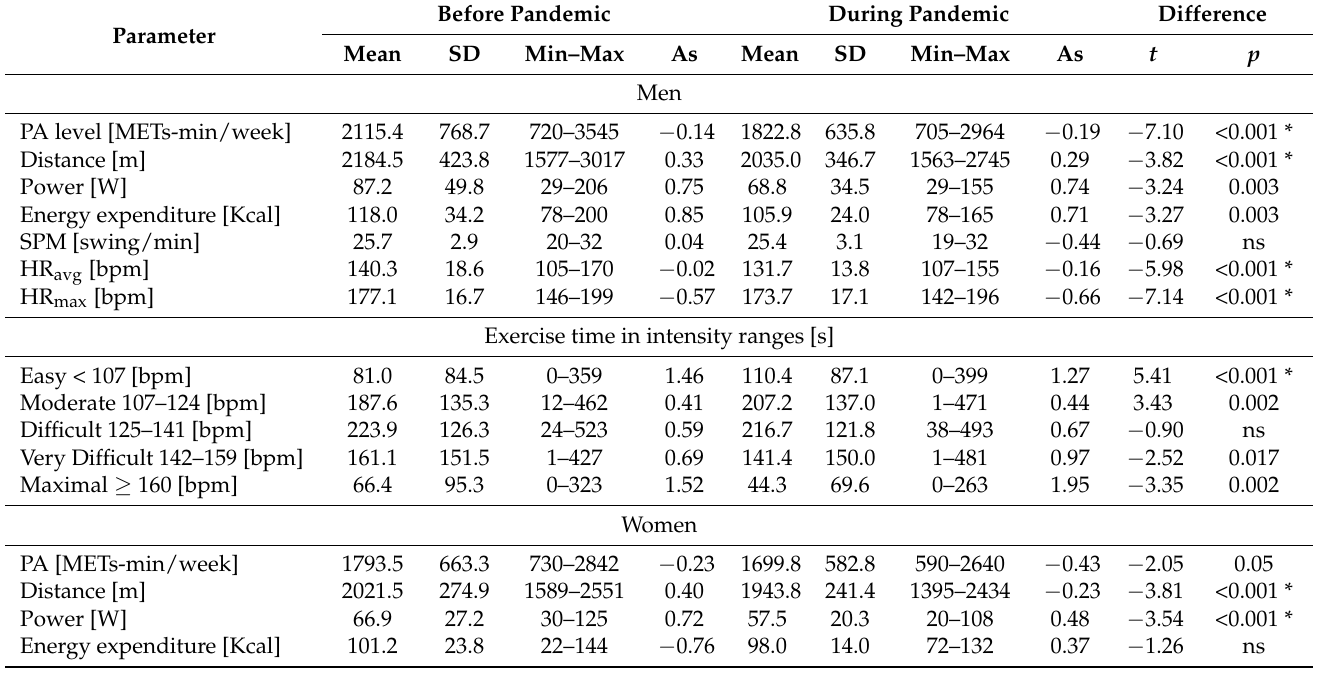
Table 5. Differences in the mean values of physiological parameters in men (N = 30) and women (N = 30) before and during the COVID-19